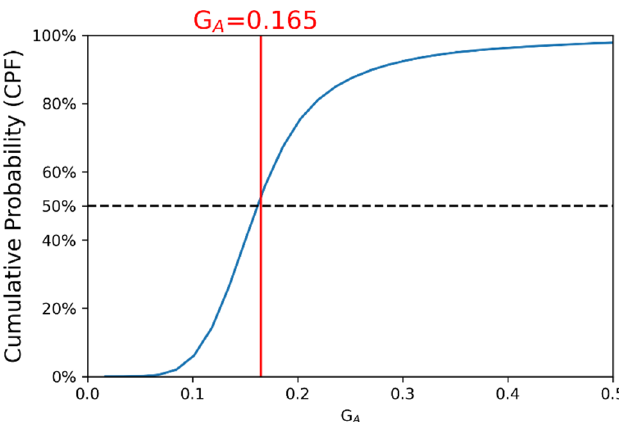
Figure 4. Cumulative probability function of G A for entire data set. G A > 0.165 means the wind is gusty. Otherwise, the wind is not gusty. The value 0.165 is chosen for best performance. The red line is G A = 0.165. The black dash line is CPF =